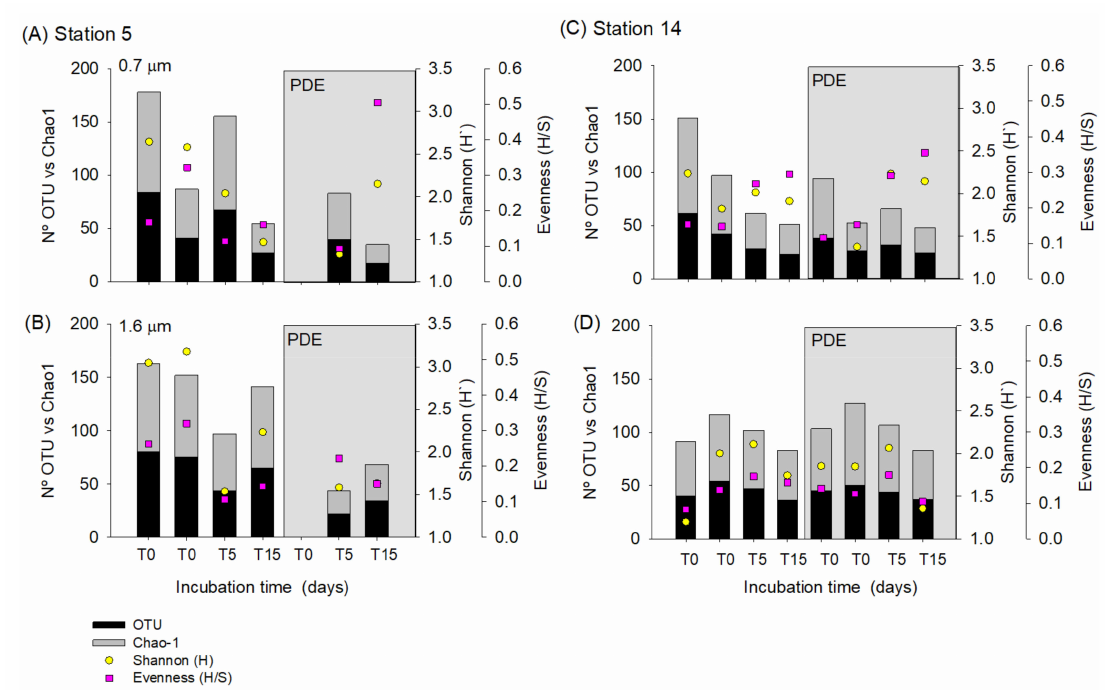
Figure 5. Richness, chao1, diversity (Shannon), and evenness in the bacterial community and over the time course of the experiment for the different treatments, with PDE addition and controls, and for the different bacterial size fractions, 0.7 µ m ( A , C ) and 1.6 µ m( B , D ). ( Left panel ) corresponds to marine station and ( Right panel ) to estuarine